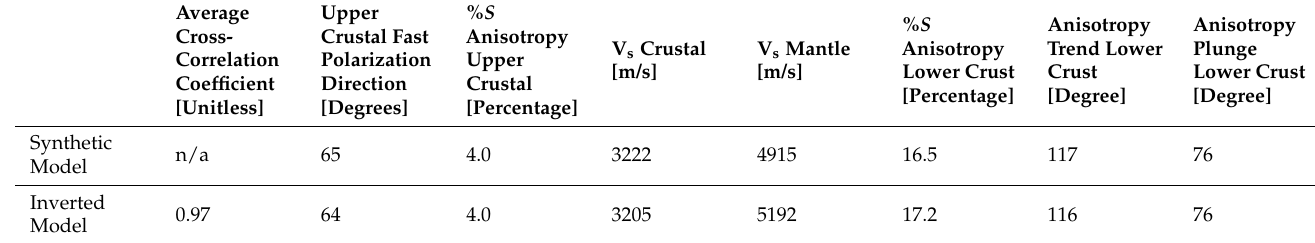
Table 2. Results from the synthetic test.